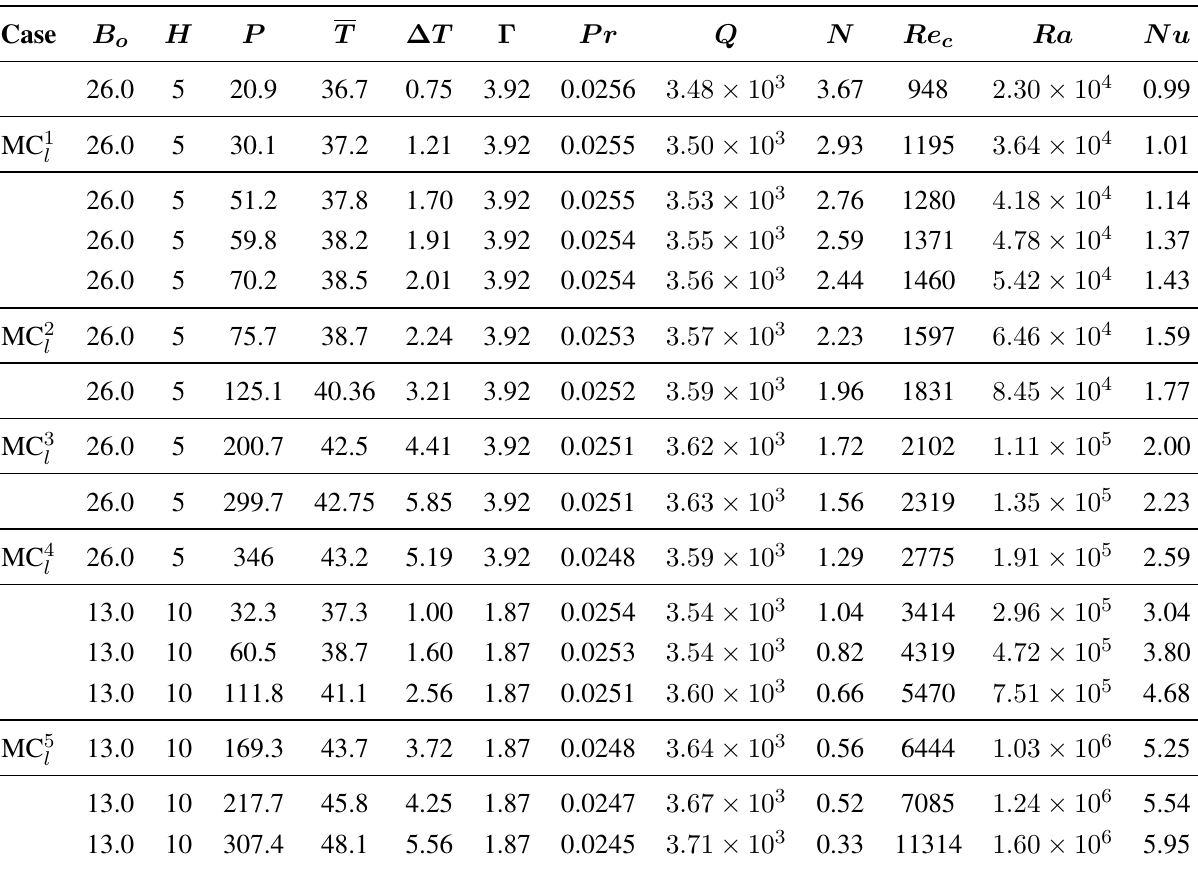
Table 5. Laboratory magnetoconvection (MC) experiments made using liquid gallium. The imposed axial magnetic field B is reported in units of mT; the tank height H is given in o units of cm; the heating power P in units of W; and the mean temperature T and the vertical temperature difference ∆ T are both given in degrees Celsius. The magnetic Prandtl number remains effectively fixed at P m = 1 . 5 × 10 − 6 in all cases.